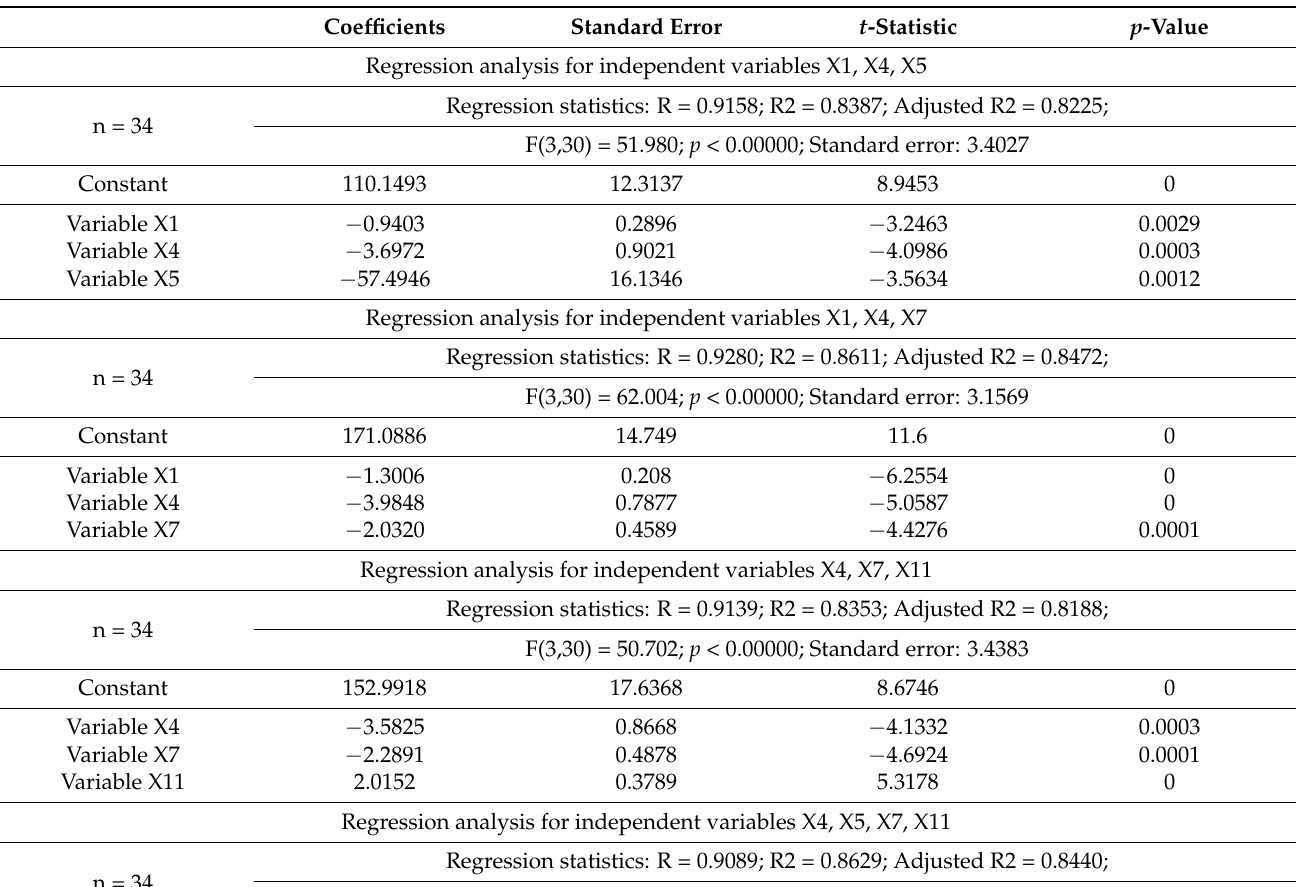
Table 3. Results of regression analysis for independent variables that show a statistically significant correlation with the fuel poverty indicator.